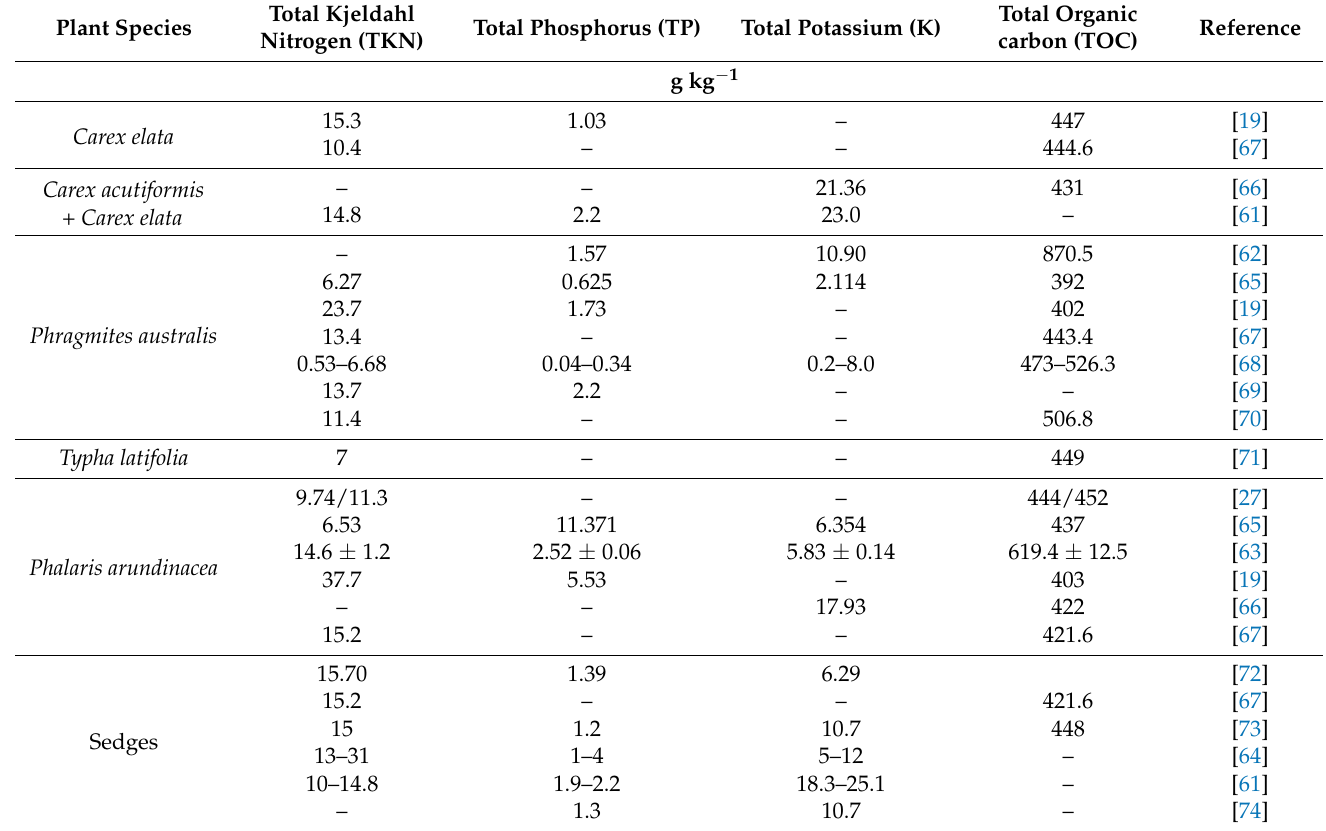
Table 6. Chemical composition of plant species according to published